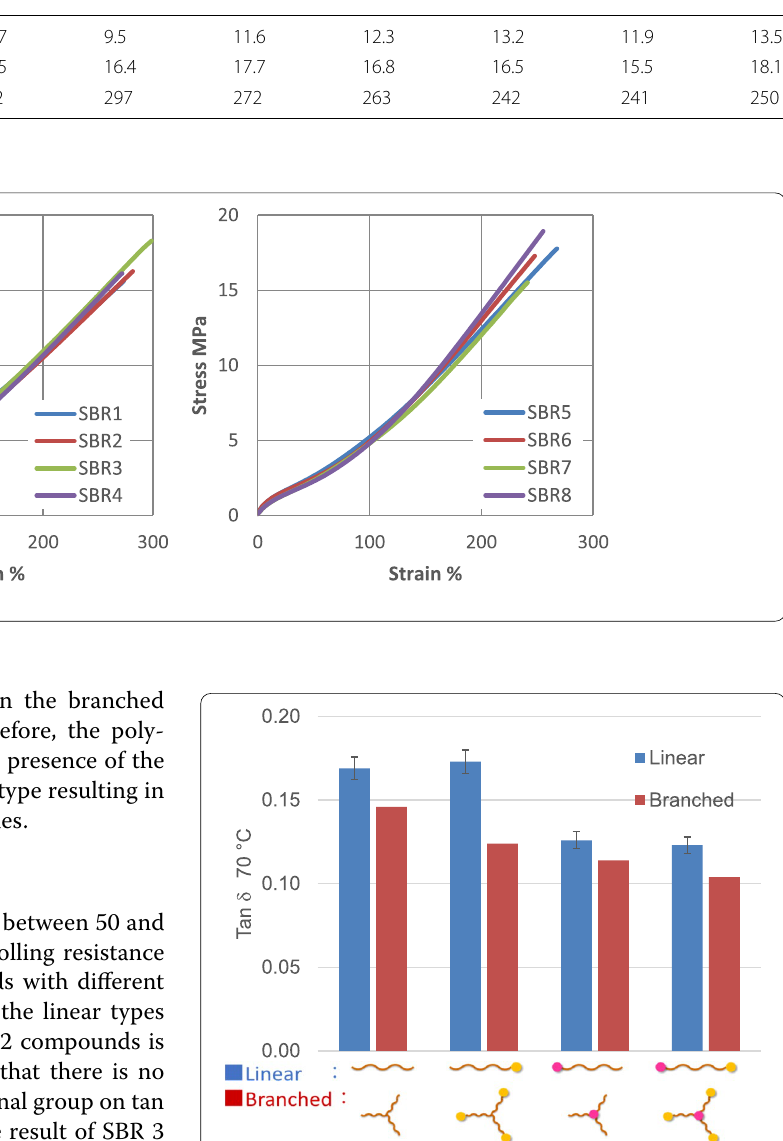
Fig. 20 tan δ of silica compounds with different types of